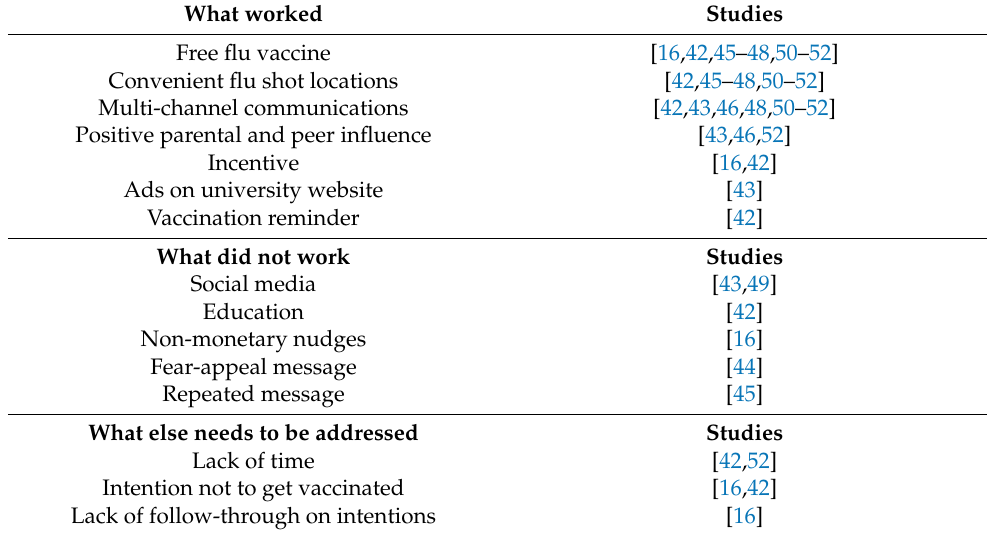
Table 5. Key learnings in influencing seasonal influenza vaccination